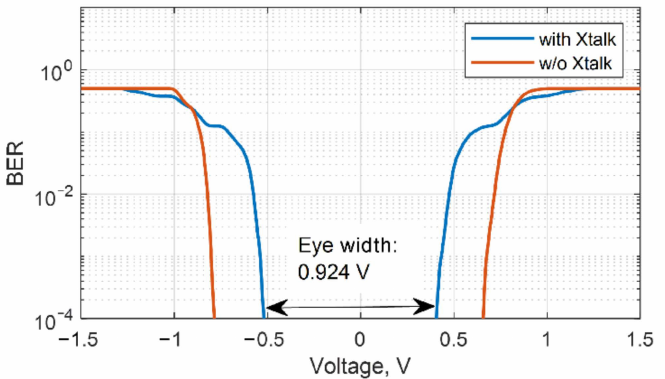
Figure 2. Bit error rate versus voltage for time 0.5 ns. Bit rate is 1